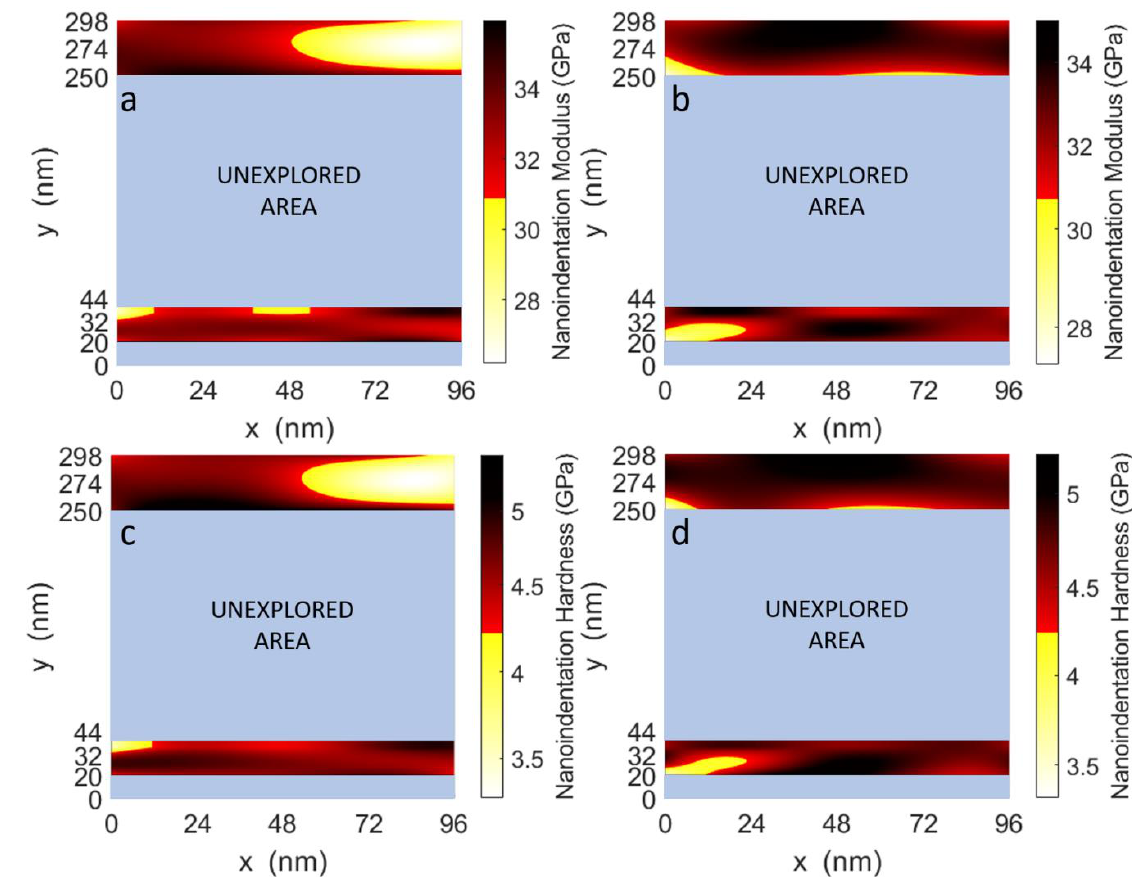
Figure 10. Representative color maps of the micromechanical properties obtained for orifice samples characterized by a diameter of 21 mm. ( a , b ) represent the distribution of the nanoindentation modulus obtained for the old deposition process and the new deposition process, respectively; ( c , d ) represent the distribution of the nanoindentation hardness obtained for the old deposition process and the new deposition process, respectively.